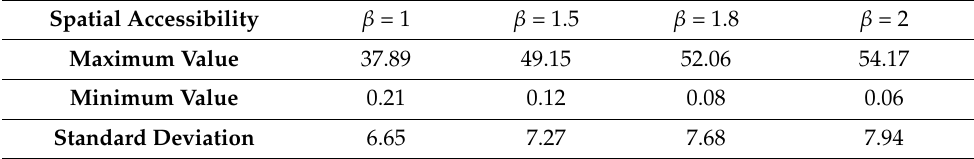
Table 3. Spatial accessibility of medical facilities with different values of friction coefficient.